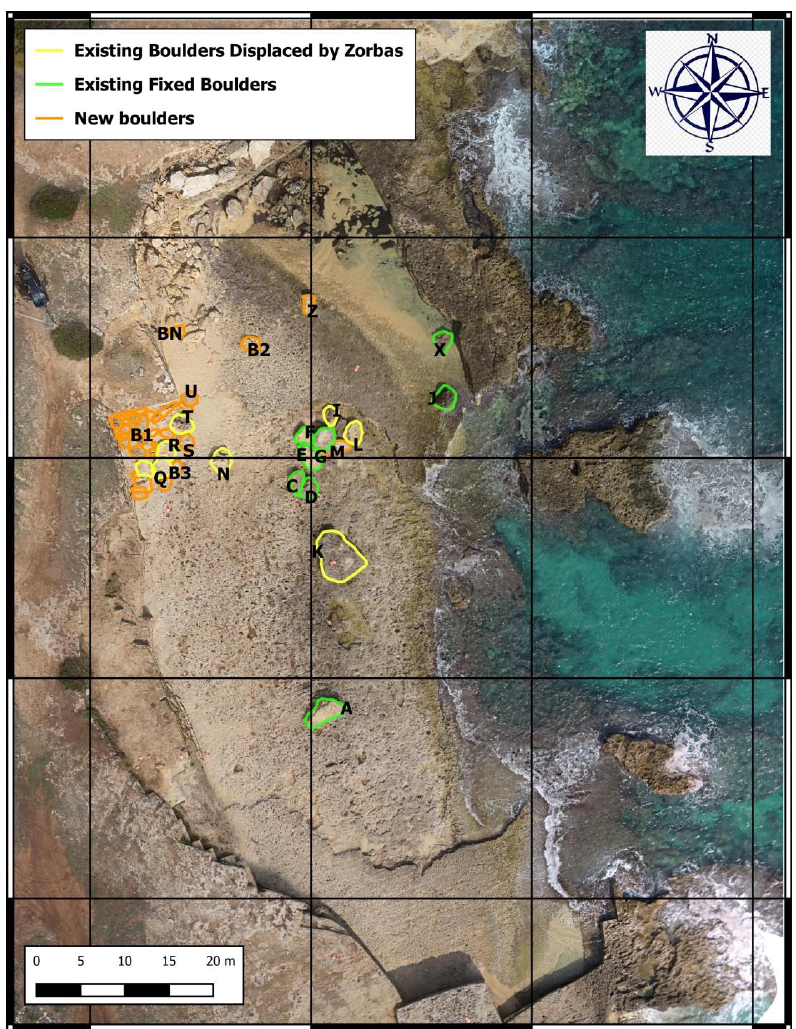
Figure 6. Boulders edited in Quantum Geographic Information System (QGIS) from the Orthophoto reconstructed after the impact of Medicane Zorbas; the boulders already present on the coastline and displaced by Zorbas are marked in yellow, the boulders detached from the coastline and dispersed on the shore-platform by Zorbas are marked in orange, and the boulders not displaced by Zorbas are marked in green.